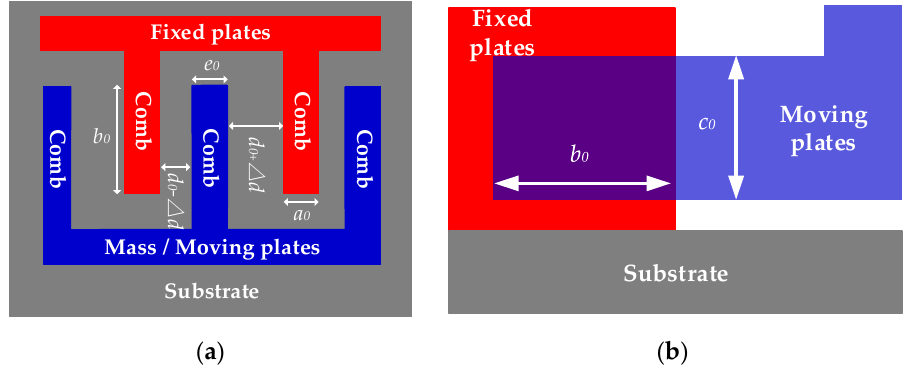
Figure 4. Combs of moving plates and fixed plates when